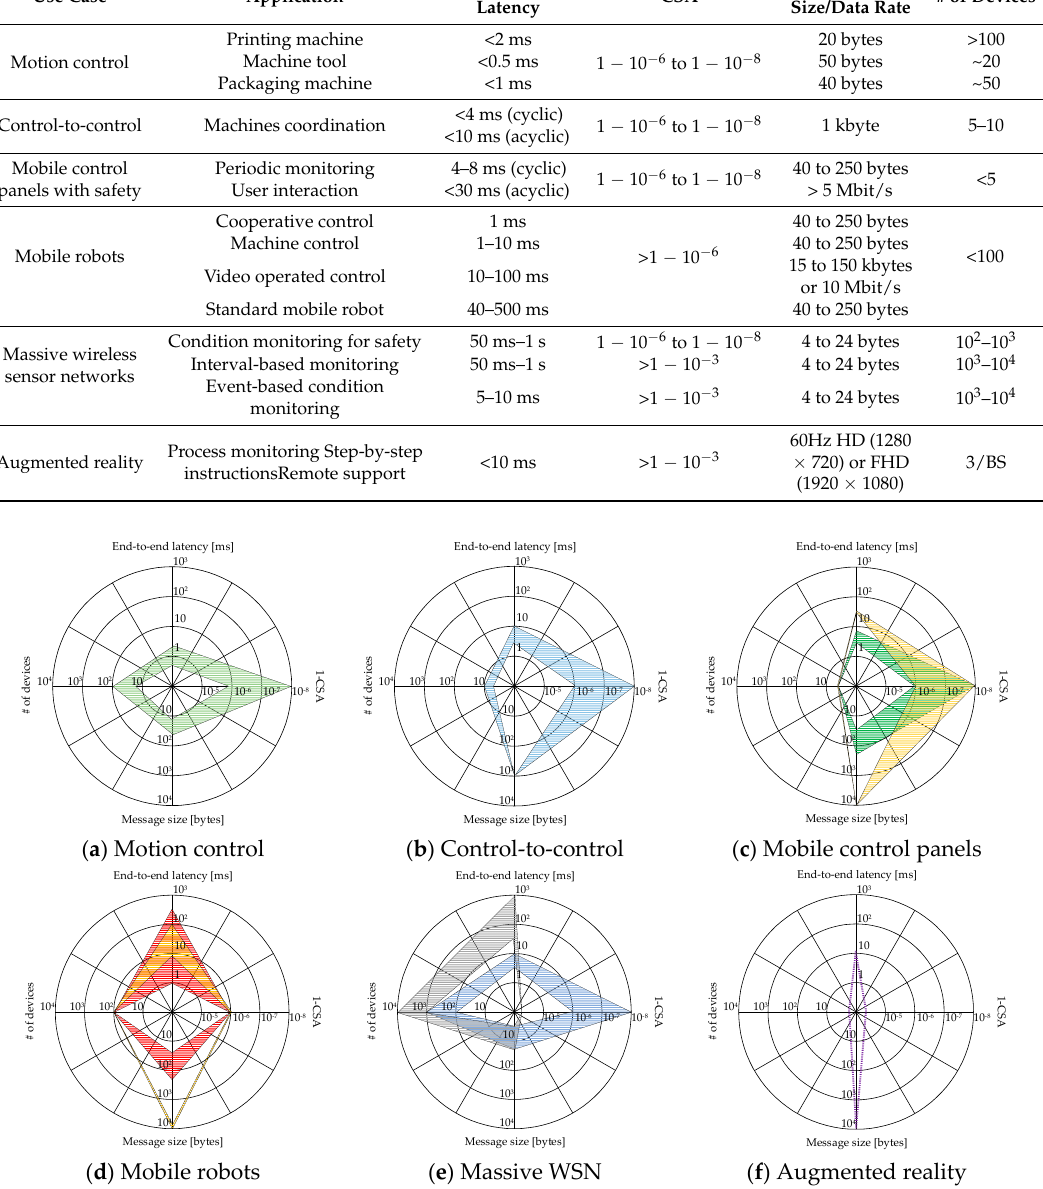
Figure 1. Requirements of selected use cases for the factory of the future. Each area represents the range of requirements identified for each use case. Some use cases have two areas to highlight that different applications will require significantly different requirements.